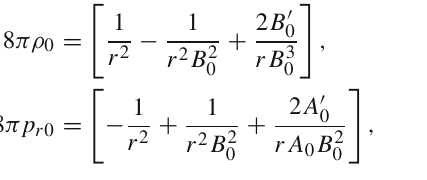
The energy momentum tensor for null radiation